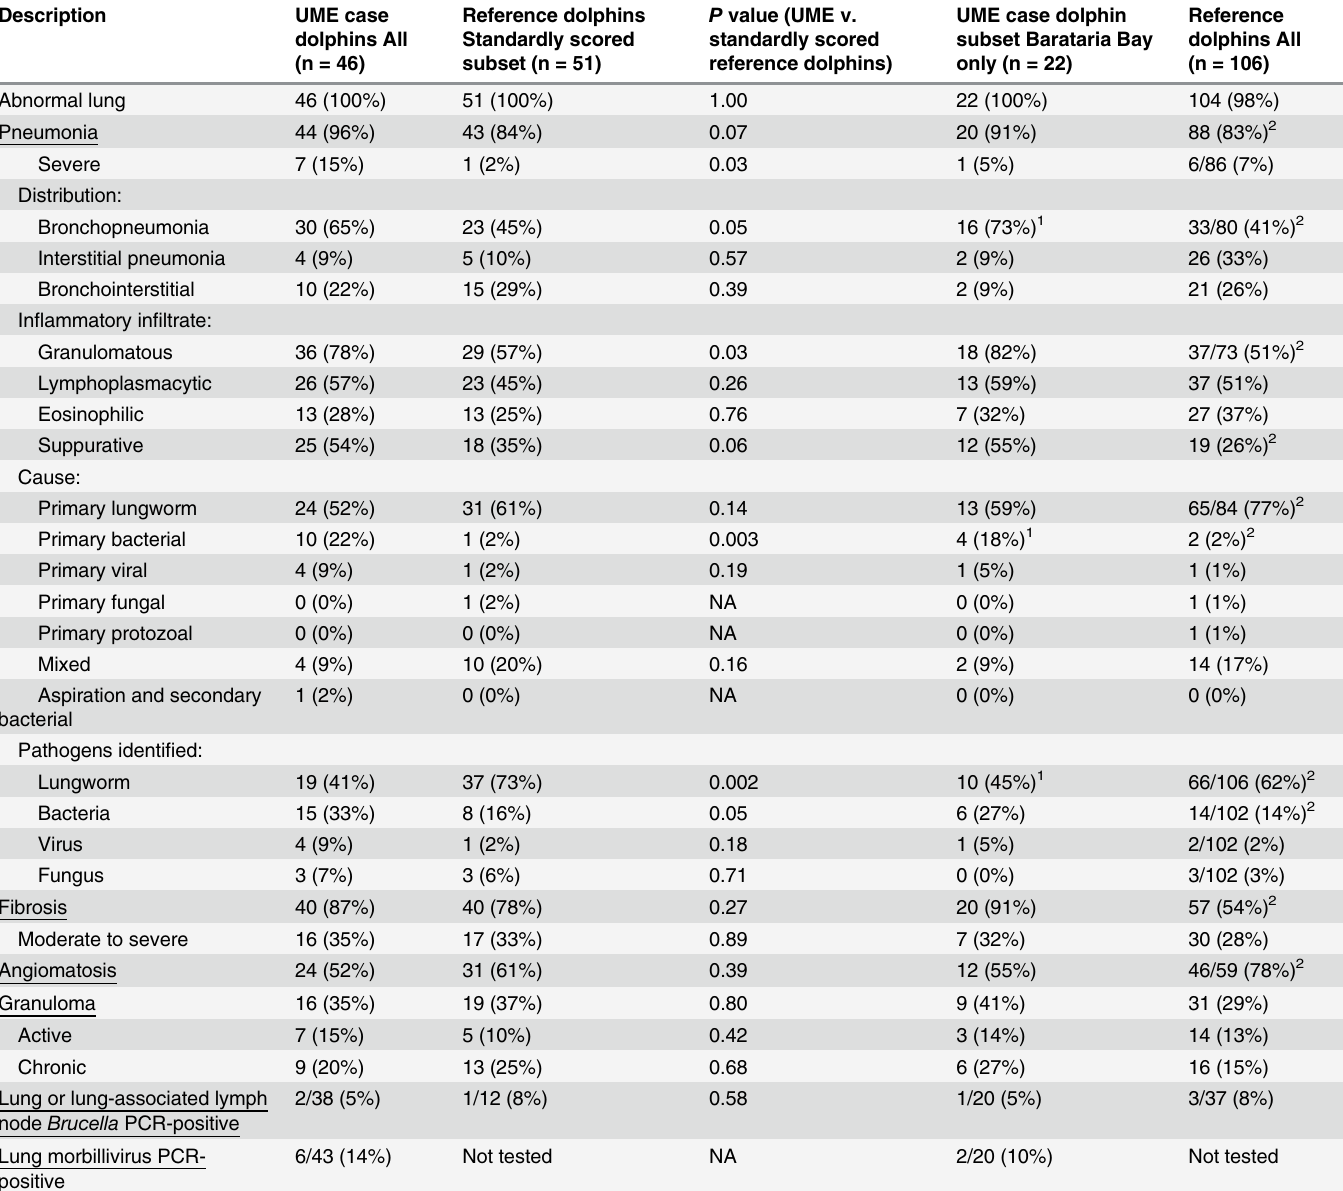
Table 3. Prevalence comparisons of lung lesions detected using histologic examination for fresh dead, stranded common bottlenose dolphins ( Tursiops truncatus ) among UME dolphins from 1) Louisiana, Mississippi, and Alabama, 2) slide-reviewed and standardly scored reference dol- phin subset, 3) Barataria Bay, Louisiana UME dolphin subset, 4) and all reference